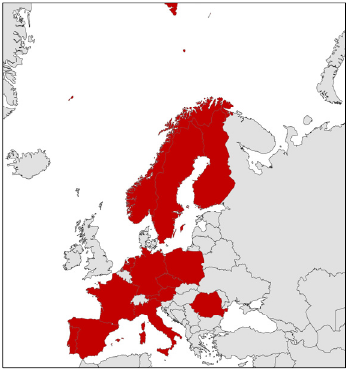
Figure 1. Countries in red have established a framework partnership agreement to support the GRC. Map generated in Esri ® ArcMap™ 10.3. Used dataset: ESRI Data and Maps-World Countries (Generalized) dataset.